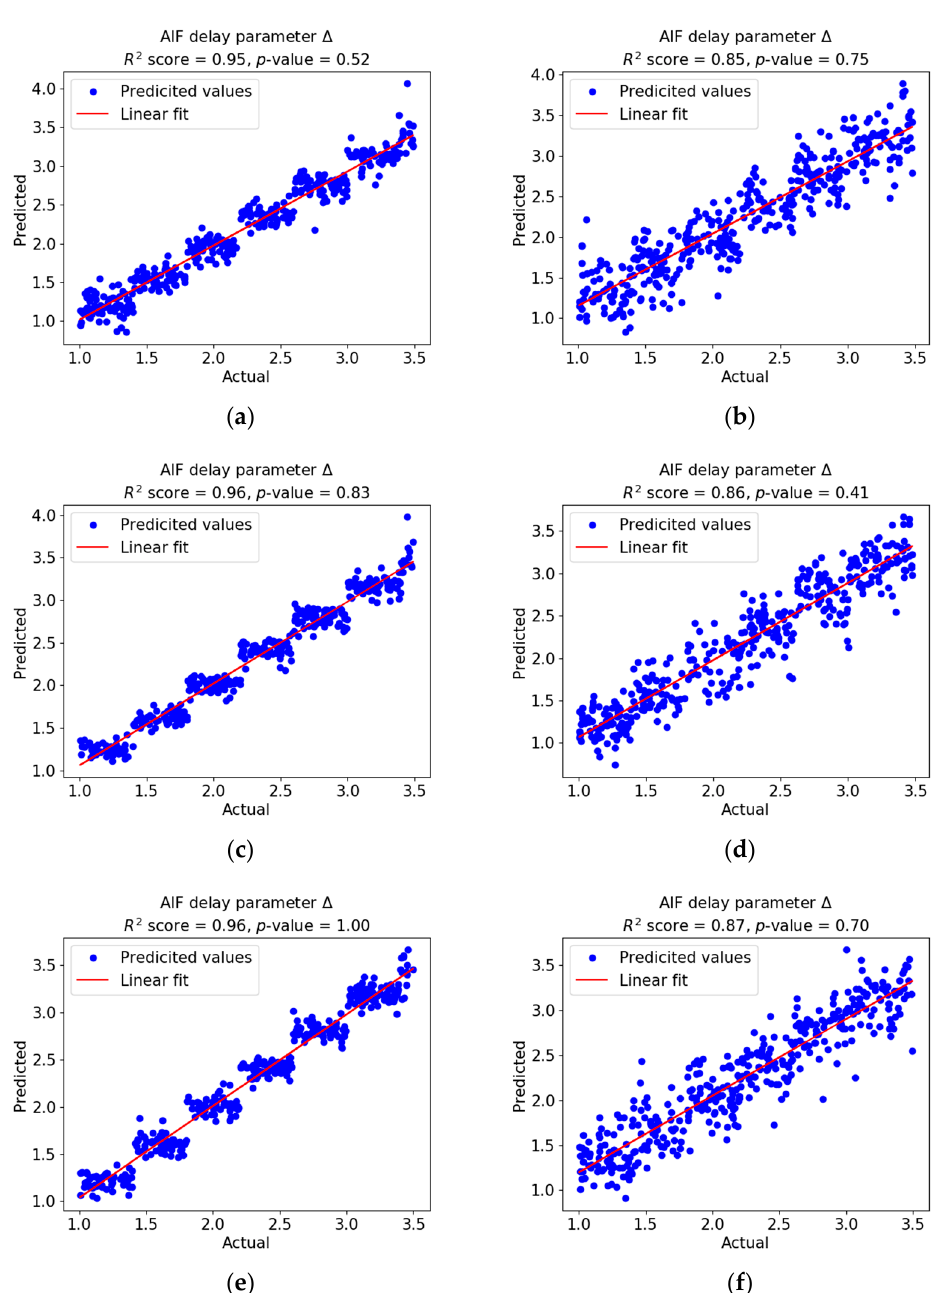
Figure 9. Predicted against actual values of the Δ parameter in the test set for three configurations of the MLP structure with the dropout layer. The number of neurons in the hidden layers: 30/15 ( a ), ( b ), 40/20 ( c ), ( d ), 50/25 ( e ), ( f ). Plots in the left and right columns represent, correspondingly, noise-free and noisy data.